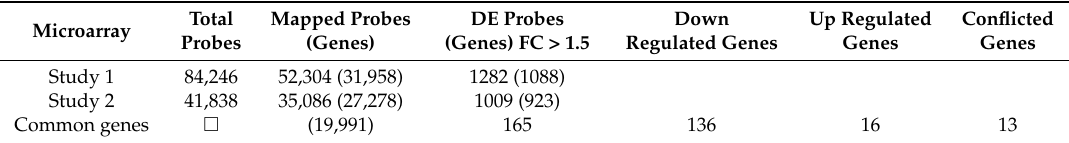
Table 2. Integration of two sets of N fertilizer response microarray data via reference genome B73.